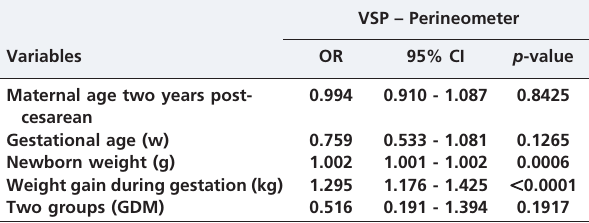
Table 4 - Estimated ß parameter, odds ratio (OR), 95% confidence interval (95% CI) and p-value obtained by adjusting the multivariate logistic model for investigating gestational